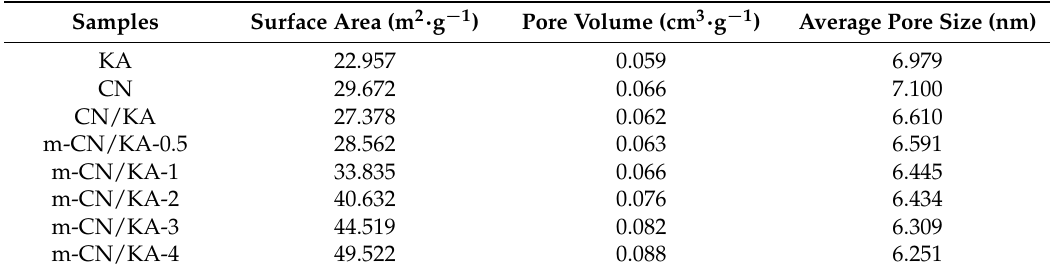
Table 1. BET surface area, pore volume, and average pore size of m-CN/KA composites with various modifier amounts.